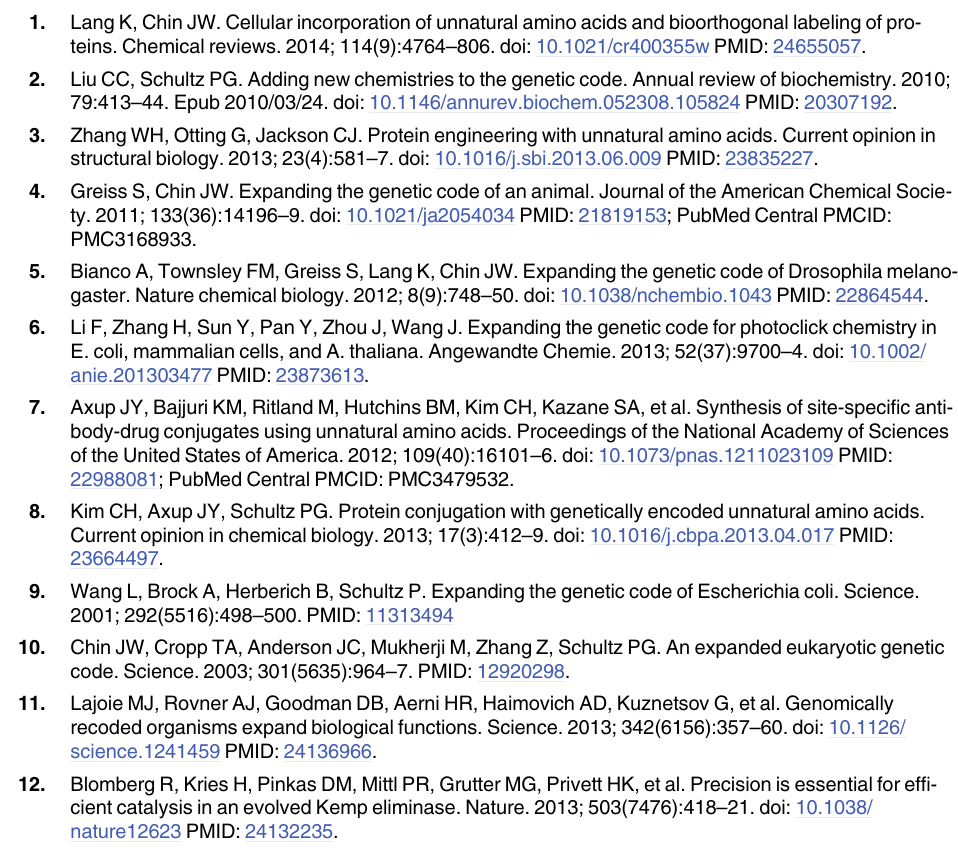
S4 Fig. SDS PAGE analysis of the soluble and insoluble cell lysate fractions of the KGF- sfGFP azF fusion variants. The band labelled K-G at ~44 kDa corresponds to the uncleaved KGF-sfGFP fusion product. All samples were standardised to set cell density (OD at 600 nm of 1.0). (TIFF) S1 Table. Oligonucleotide primer